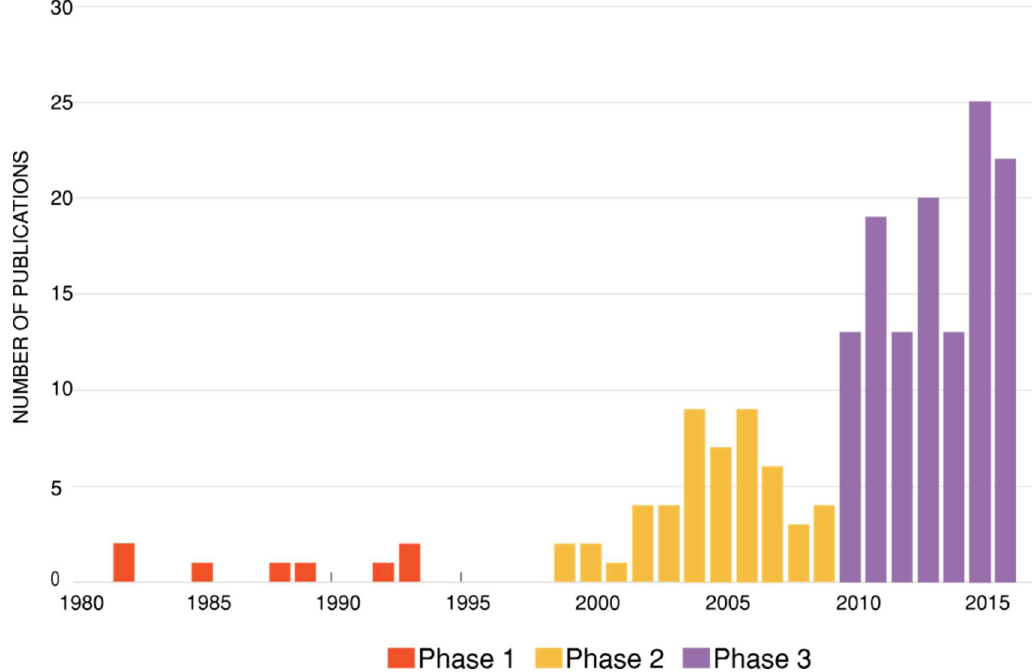
Figure 3. Number of peer-reviewed publications per year, between 1982 and 2016, indicating three distinct phases of scientific publications.